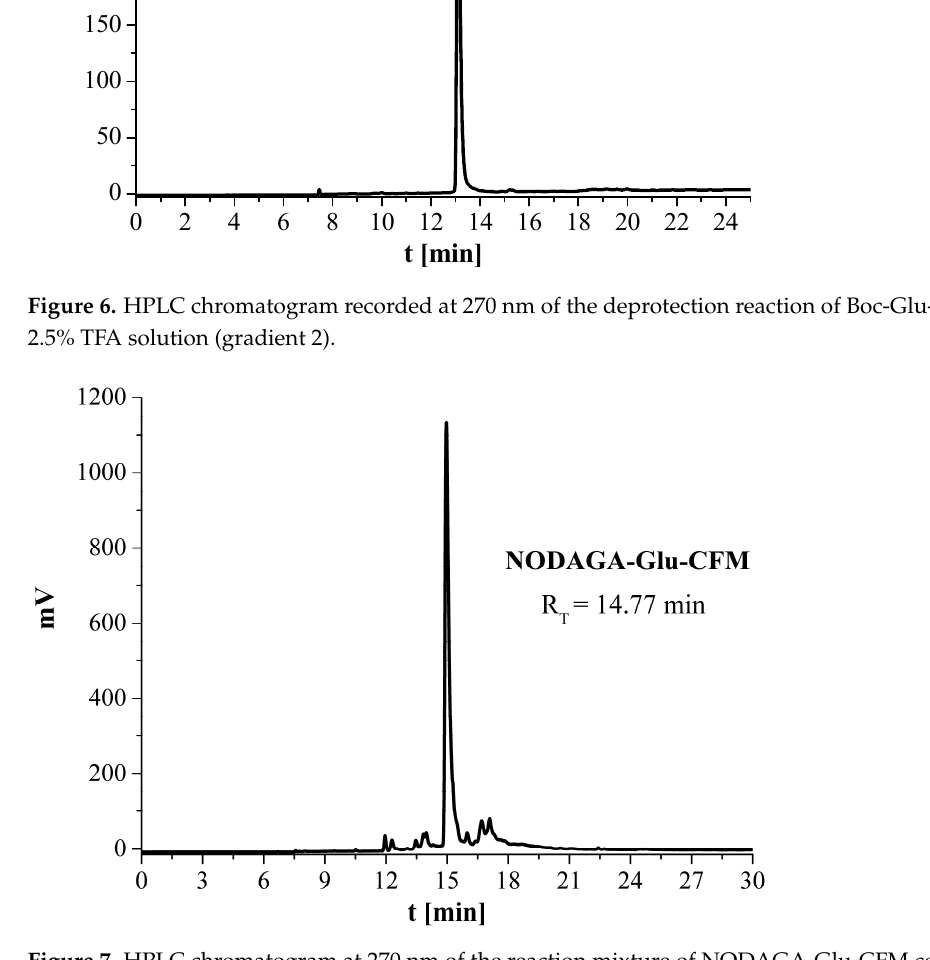
Figure 7. HPLC chromatogram at 270 nm of the reaction mixture of NODAGA-Glu-CFM conjugate (R t = 14.77 min) synthesis (gradient 2).